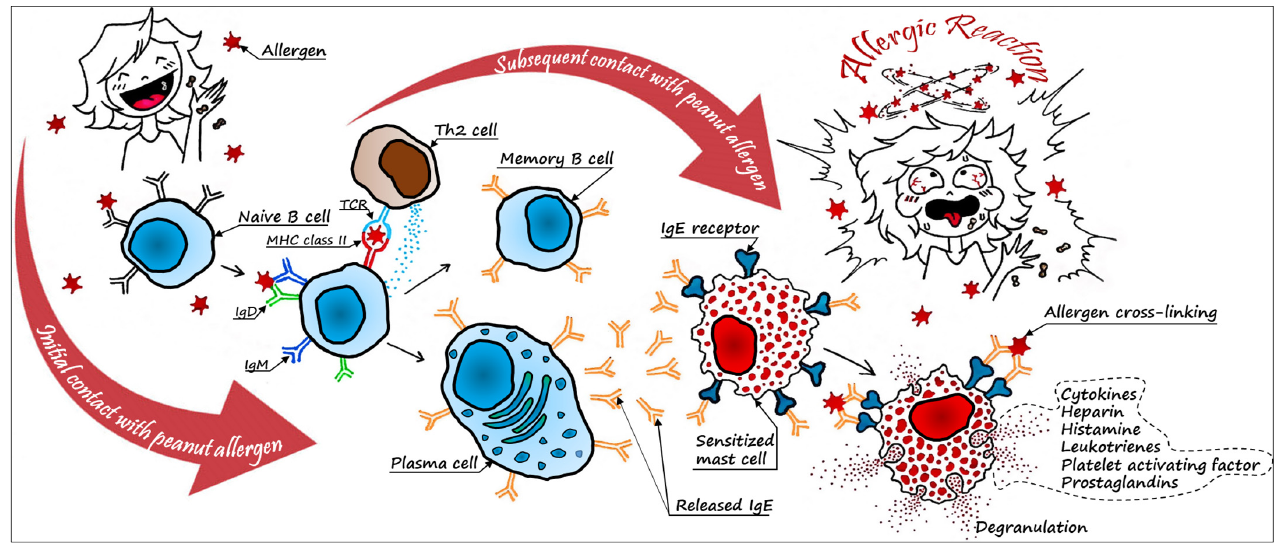
Figure 1. The mechanism of allergic reaction to peanuts.